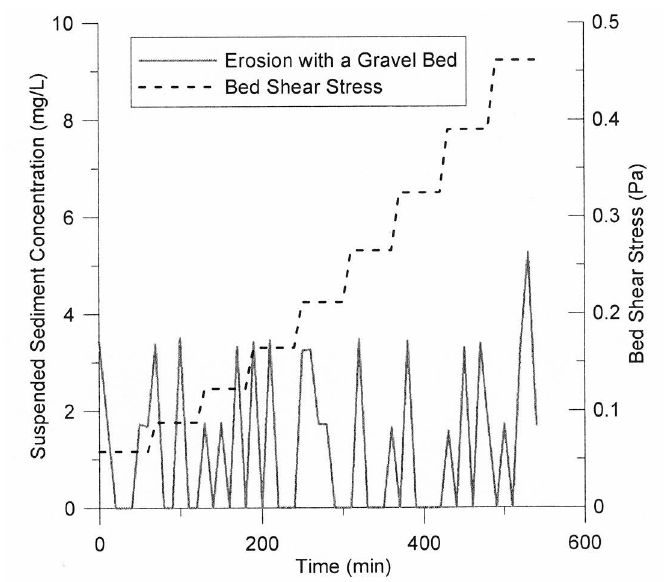
Fig. 4 Erosion experiment with coarse gravel